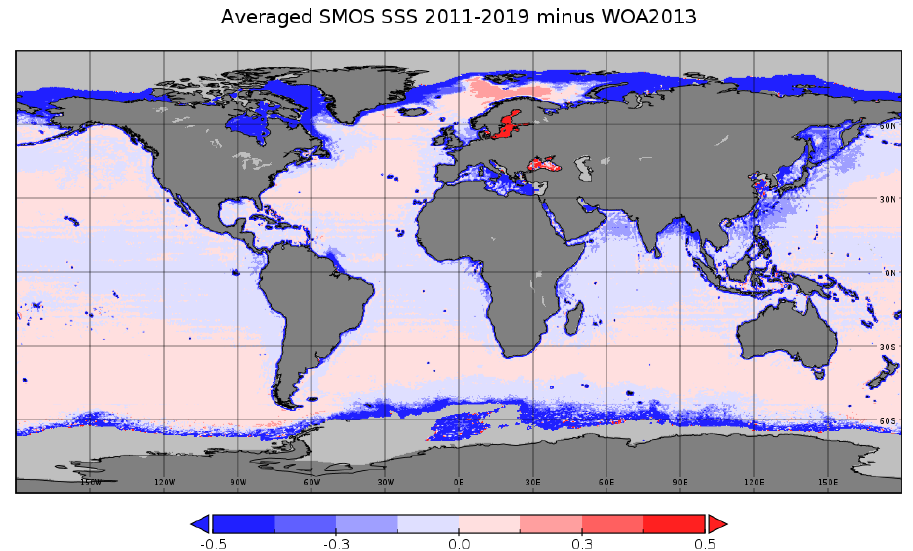
Figure 3. Difference between the 2011–2019 average of BEC SSS maps after applying corrections described in Sect. 2.2.1, 2.2.4, and 2.2.5 and WOA2013